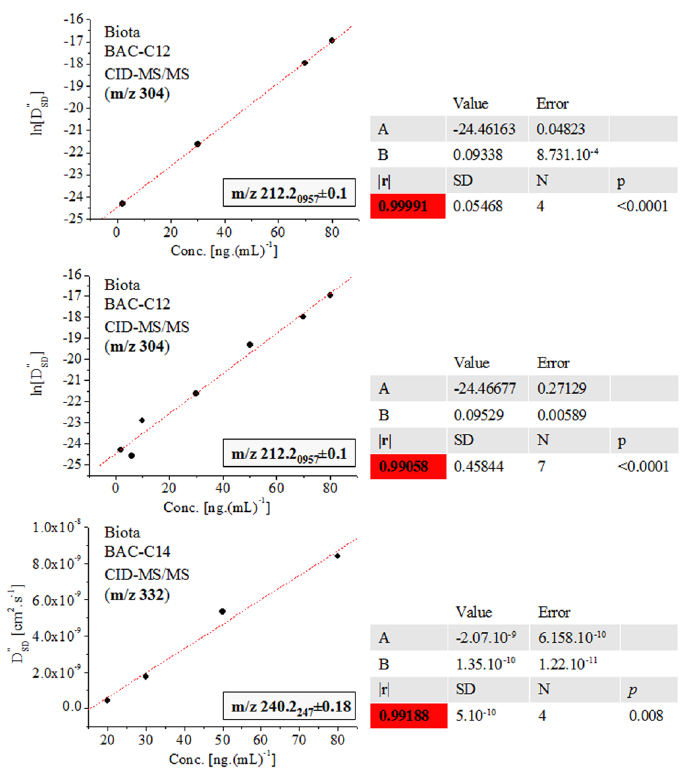
Int. J. Mol. Sci. 2023 , 24 , x FOR PEER REVIEW Figure 5. Linear functional relations ln[ D” SD ] = f(conc.) and D” SD = f(conc.) of fragmentation ions at m / z 212.2 096 and 240.2 247 of SRM spectra of molecular cation [M] + at m / z 304 and 332 of surfactants BAC-C12 and BAC-C14 in biota; chemometrics; the coefficient of correlation is highlighted in red.